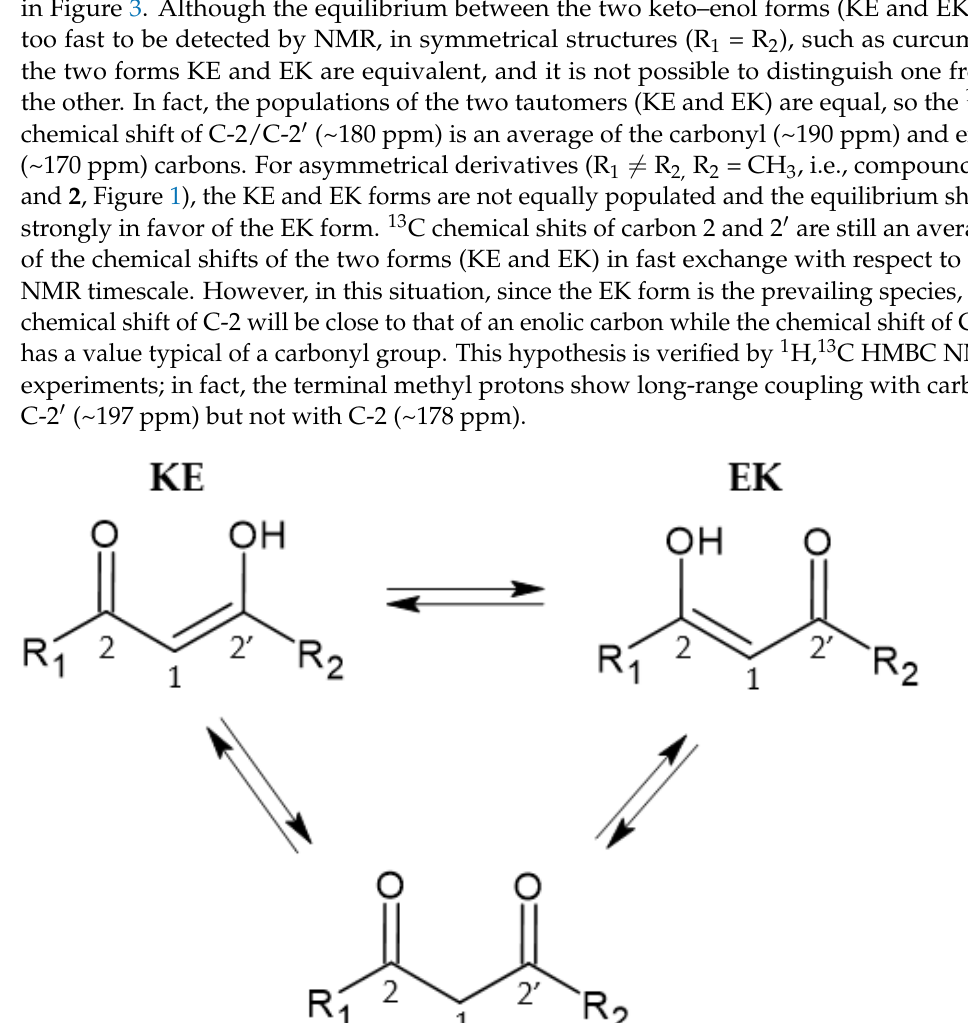
Figure 3. Schematic representation of tautomeric equilibria.